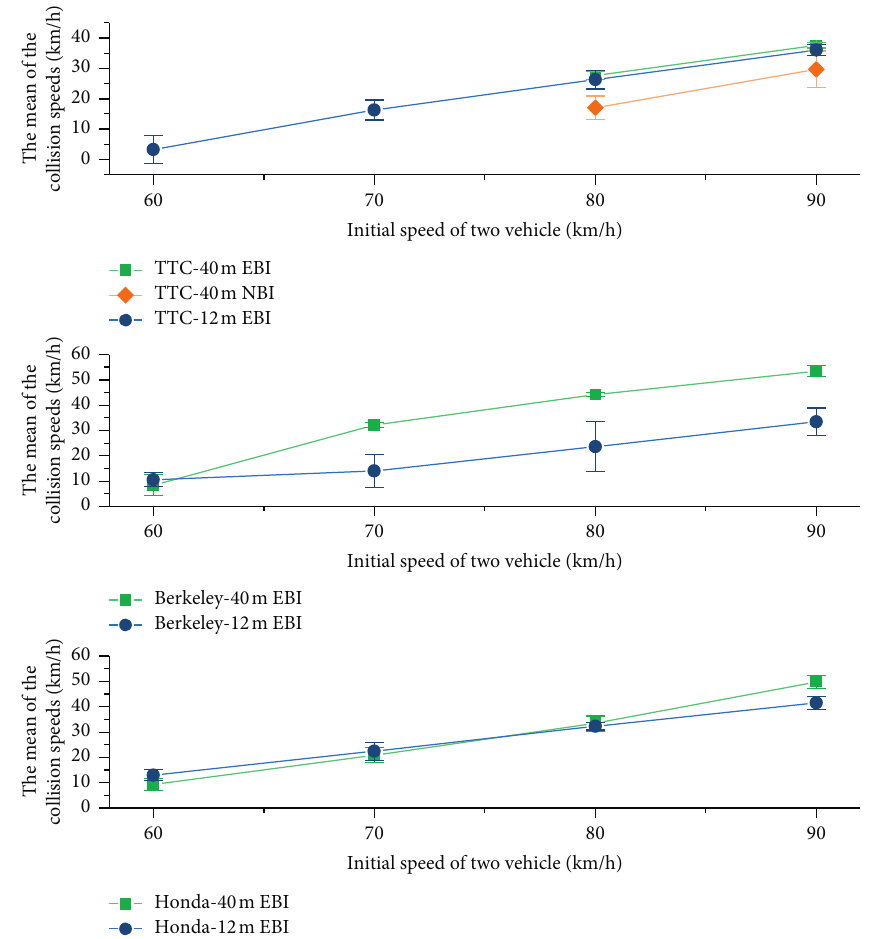
Figure 11: The vehicle speed distribution of each model in the event of